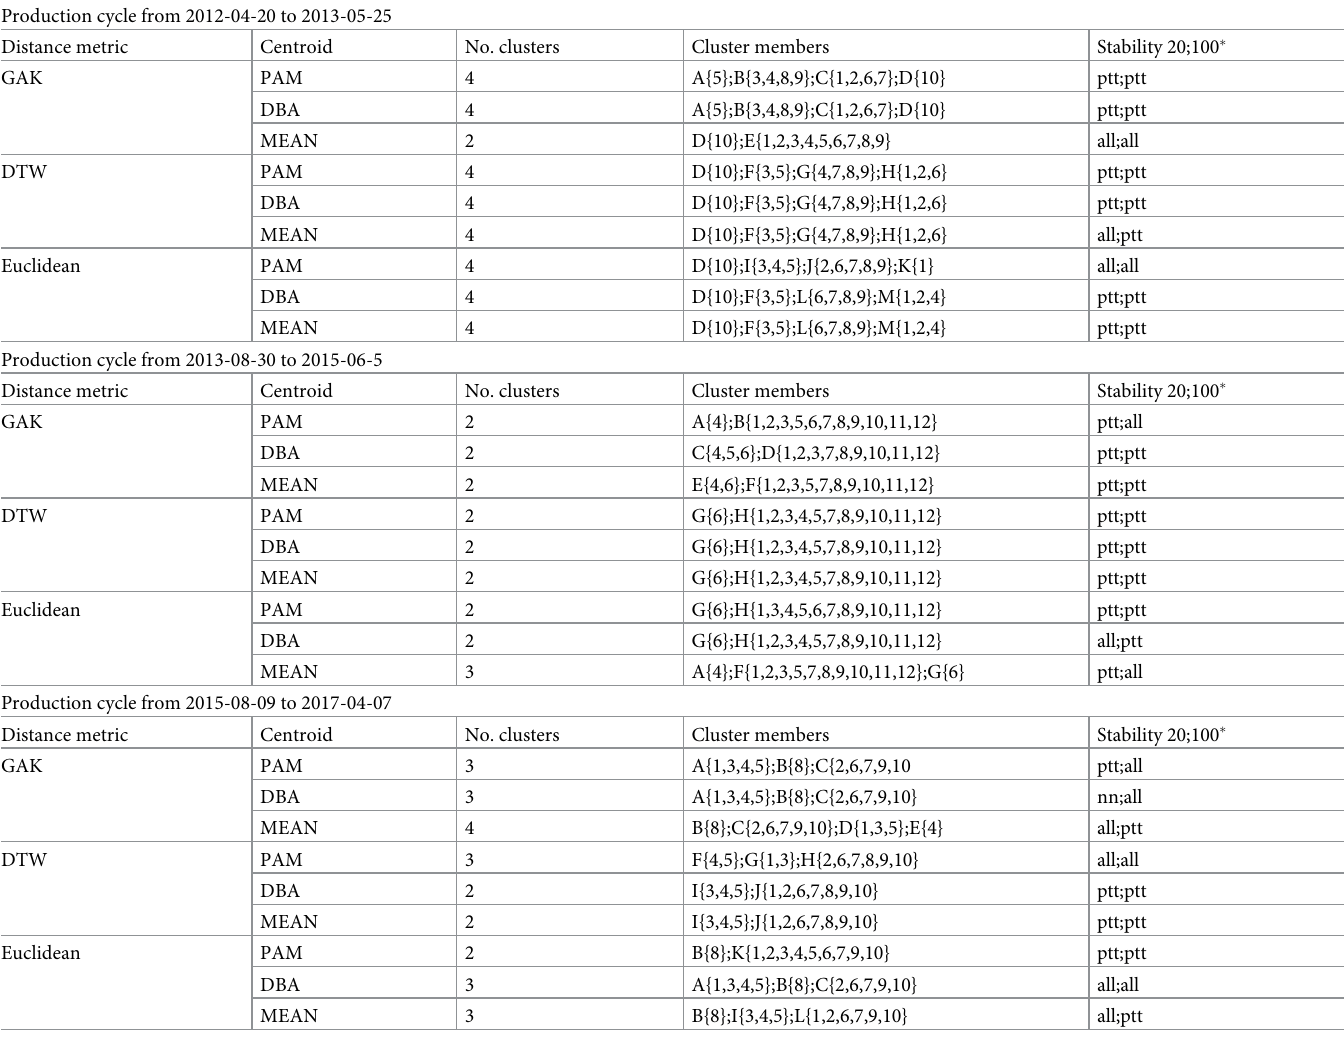
Table 3. Clustering results for Farm II. The most stable clusters are identified per cycle, alphabetically. Production cycle from 2012-04-20 to